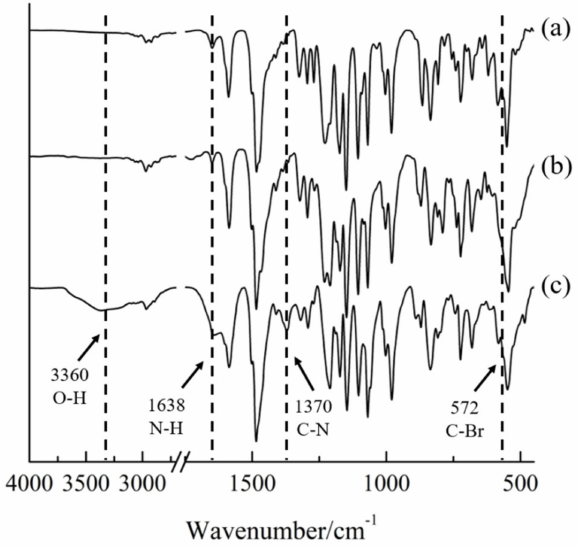
Figure 4. FT-IR of ( a ) PAES, ( b ) Br-PAES, ( c )